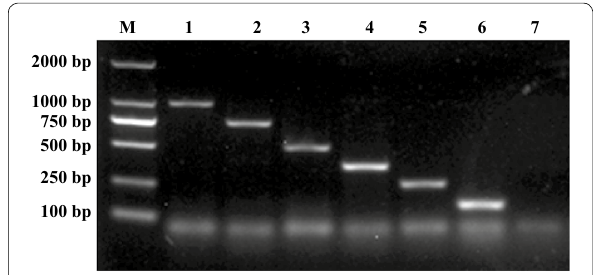
Fig. 1 Amplification of target gene of the multiplex PCR. Lane M: 2000 bp DNA marker; Lanes 1–6: the template of m-PCR respectively were Escherichia coli, Pasteurella multocida, Proteus mirabilis, Pseudomonas aeruginosa, Salmonella spp. and Staphylococcus aureus ; Lane 7: negative control